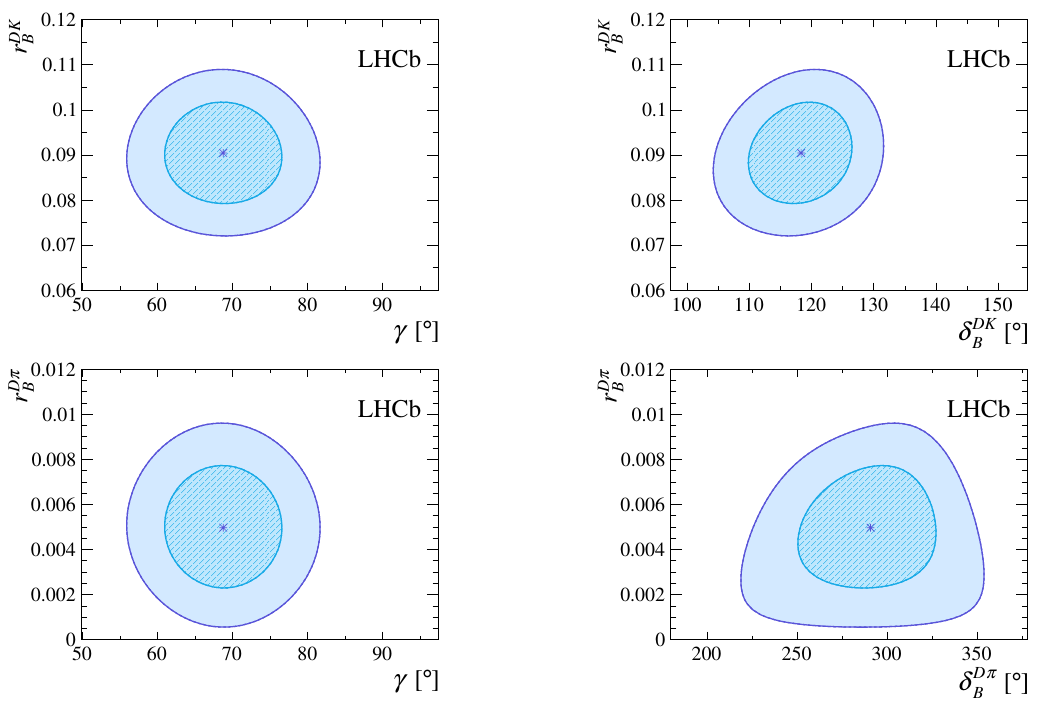
Figure 8 . The 68 % and 95 % confidence regions for combinations of the physics parameters ( γ, r DK , δ DK , r Dπ , δ Dπ ) obtained using the methods described in ref. B B B B